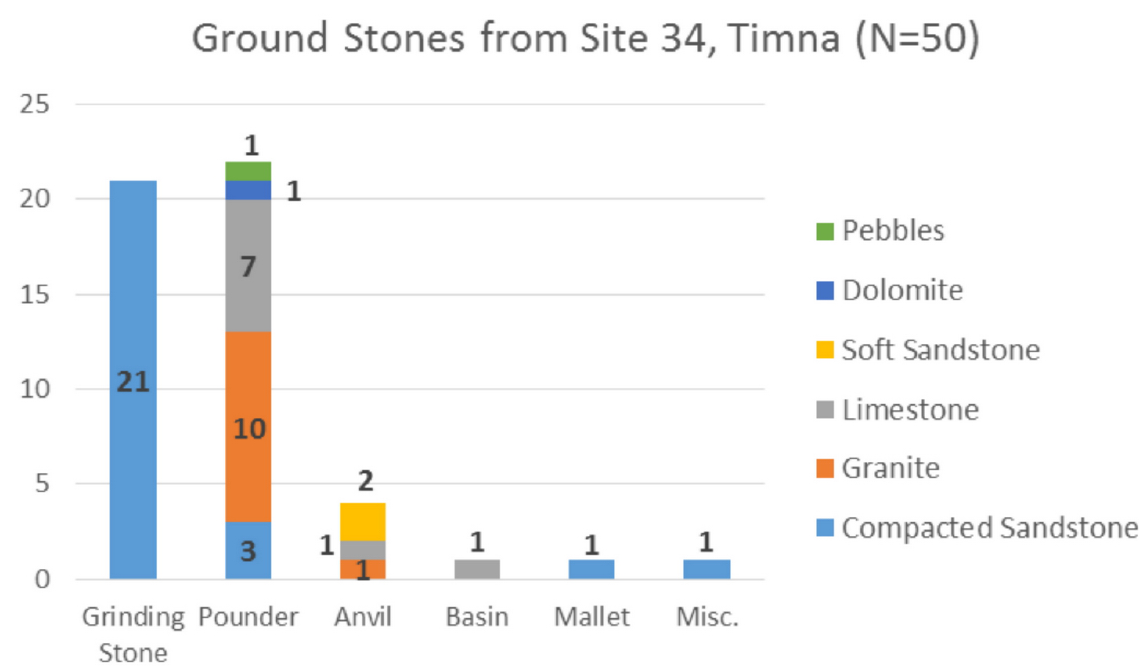
Figure 16. The rock types from which the Site 34 ground stone tools were manufactured.